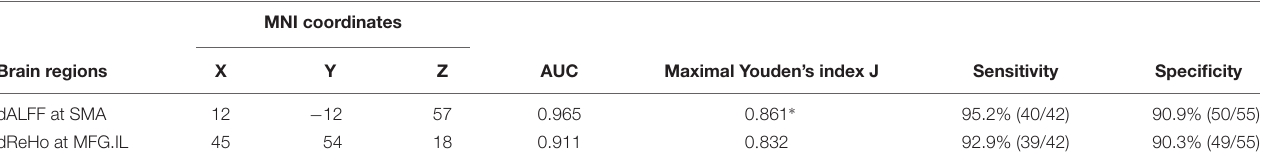
TABLE 4 | ROC analysis for differentiating stroke patients from healthy